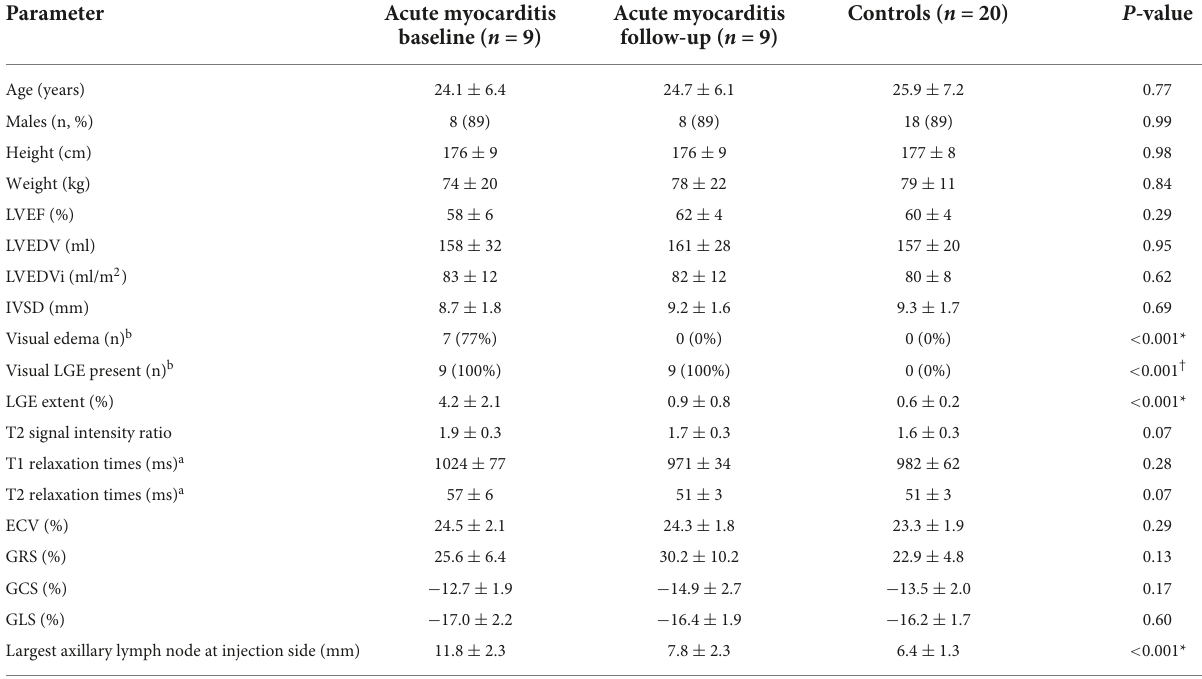
TABLE 1 Patient characteristics and cardiac magnetic resonance findings.